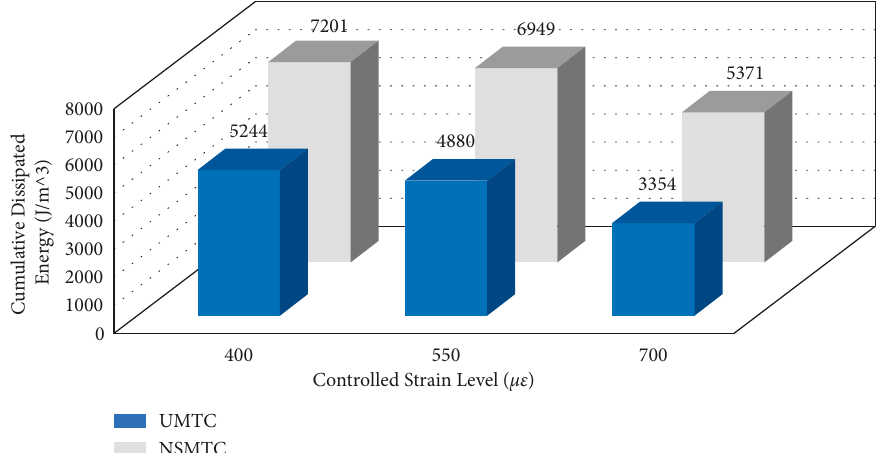
Figure 5: Cumulative dissipated energy of UMTC and NSMTC specimens at the controlled strain levels of 400, 550, and 700 με